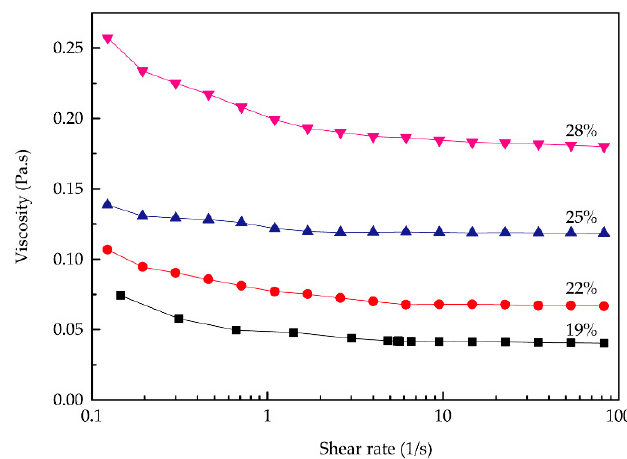
Figure 2. Rheological curves of the RSF solutions with different concentrations.